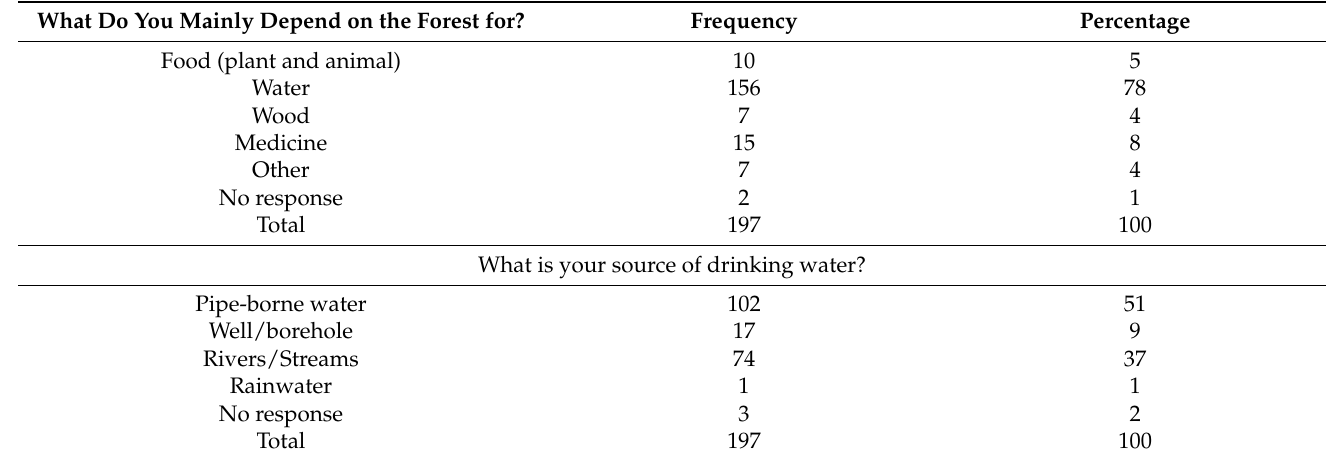
Table 2. Products and derivatives from the forest reserve.